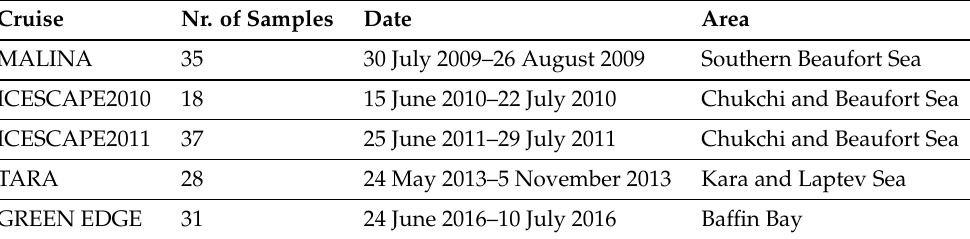
Table 1. Summary of the Arctic